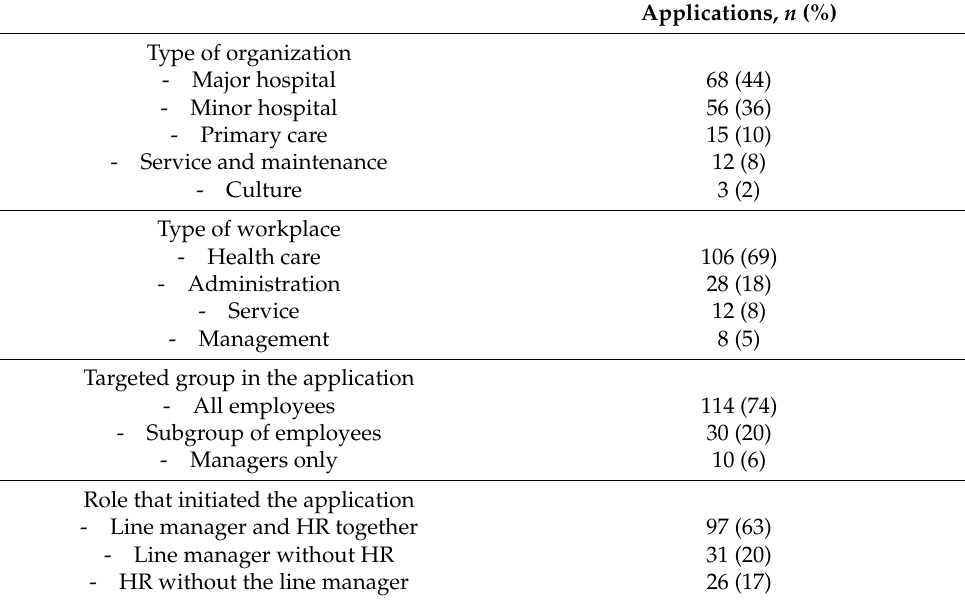
Table 1. Descriptive background data for the workplaces behind the 154 applications submitted to the